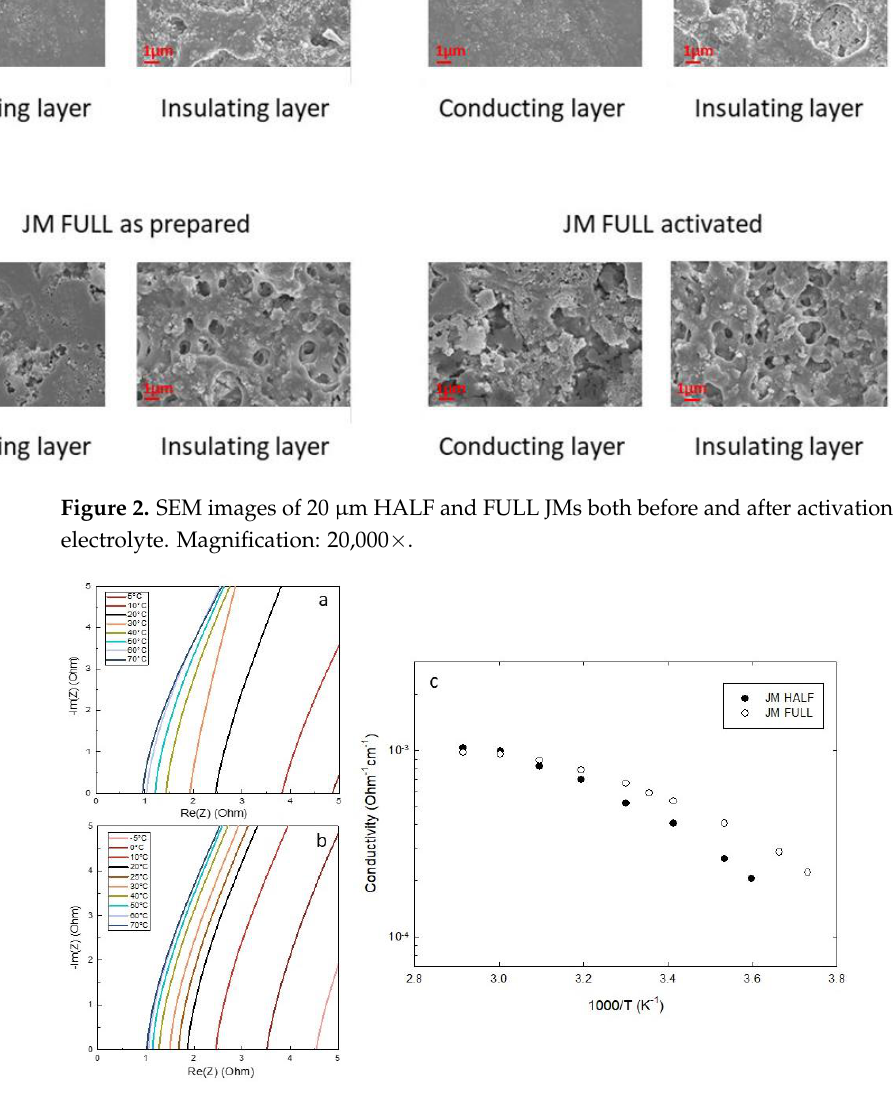
Figure 3. High-frequency intercept of the EIS Nyquist plots of ( a ) HALF and ( b ) FULL JMs. ( c ) Ar- rhenius plot of the ionic conductivity of the JMs. Table 1 . VTF best-fit parameters of the data reported in Figure 2c. 𝑘 𝐵 is the Boltzmann constant.